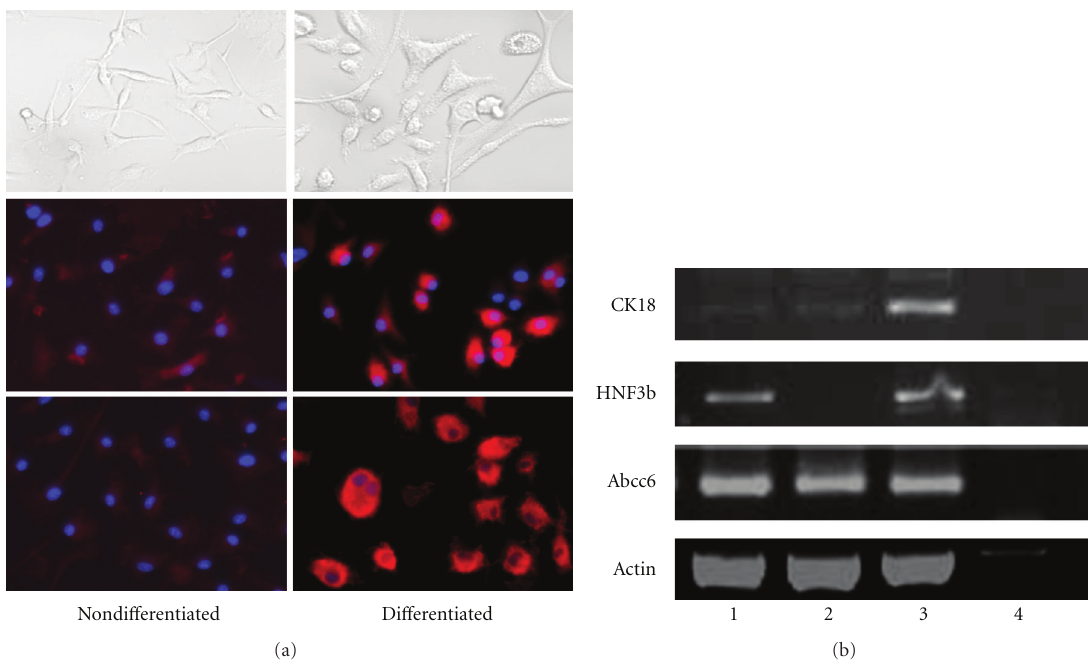
Figure 3: Hepatocytic di ff erentiation capacity of mouse bone marrow stem cells in vitro . The cells at passage 5 were cultured either in the regular stem cell culture medium (a, left panels) or in the di ff erentiation-inducing medium (a, right panels). As observed by phase contrast microscopy at day 8 (top panels), the cells became extended and larger in the di ff erentiation-inducing medium (a, right top). Immunofluorescent analysis was performed at day 8 of di ff erentiation. Cells were stained with antibodies to liver-specific marker proteins, albumin (a, middle panels), or CK-18 (a, bottom panels). DAPI staining was used to identify the nuclei (blue). Strong signals were observed in the cells cultured in the di ff erentiation-inducing medium (a, right middle and bottom panels), while weak signal (a, left middle and bottom panels), if any, was detected in the cells cultured in the regular stem cell medium. (b) RT-PCR was conducted and the mRNA levels of di ff erent liver-specific genes were examined. They are cytokeratin-18 (CK-18), hepatocyte nuclear factor 3b (HNF3b) and Abcc6 , respectively. Lane 1: cultured cells in di ff erentiation-inducing medium; lane 2: cultured cells in stem cell culture medium; lane 3: MLE-10 (mouse liver epithelial cell line); lane 4: H 2 O blank.